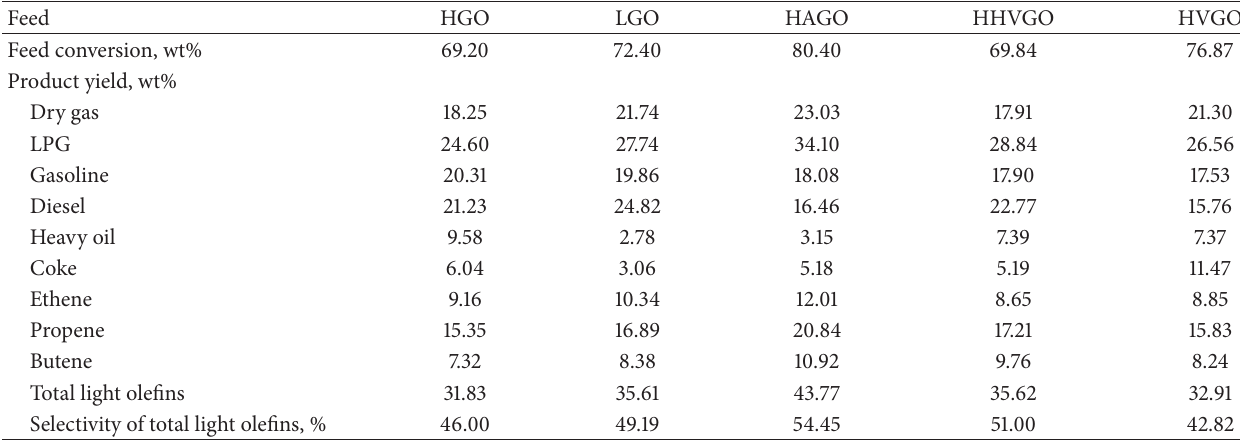
Table 3: Feed conversion and product yield of various feeds at 640 ∘ C.